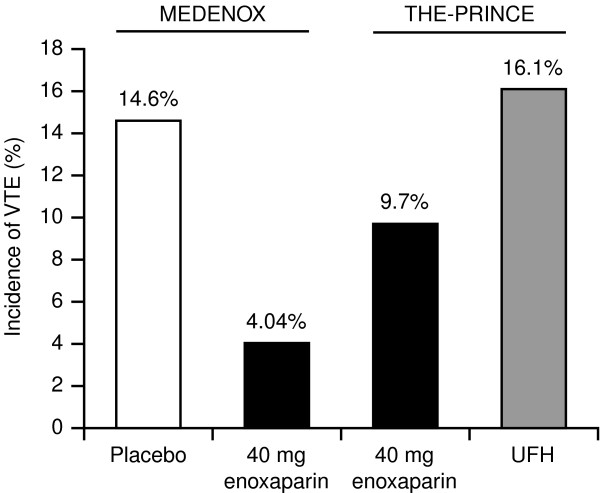
Incidence of VTE in congestive heart failure patients from the MEDENOX and THE-PRINCE studies [3, 34]. P-values were calculated using Fisher's exact test comparing pooled enoxaparin 40 mg data from the MEDENOX and THE-PRINCE studies with the placebo data from MEDENOX and the UFH data from THE-PRINCE. UFH, unfractionated heparin; VTE, venous thromboembolism.